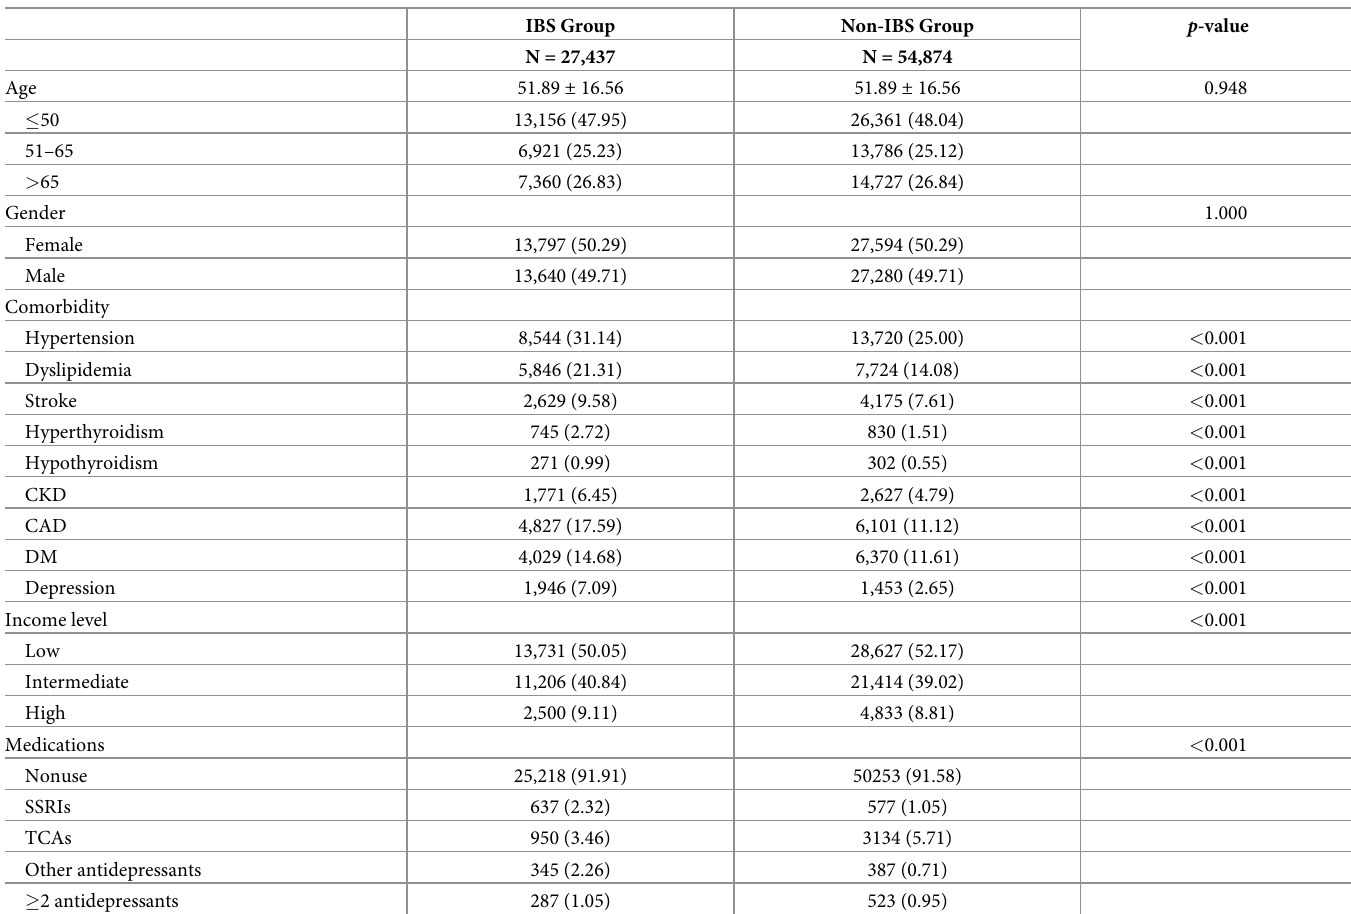
Table 1. Baseline demographic factors and comorbidity of the study